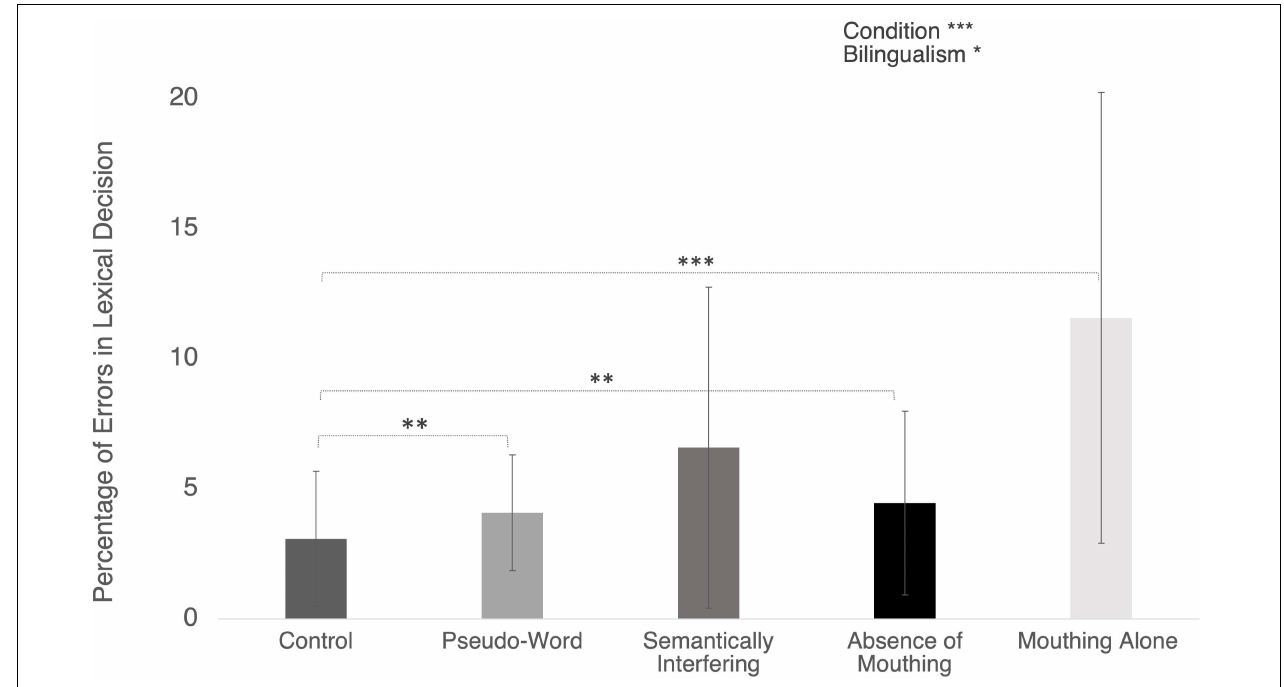
FIGURE 2 | Error rates (in percentage) in the different conditions. Error bars represent standard deviations. Significant post hoc comparisons are indicated with conventional asterisks ( ∗ p < 0.05; ∗∗ p < 0.01; ∗∗∗ p < 0.001).